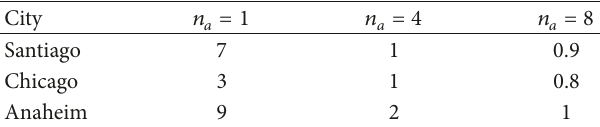
Table 3: Trip matrix weighting factor (∗) that generates the maximum value of 𝜙 as a function of the 𝑛 𝑎 value.